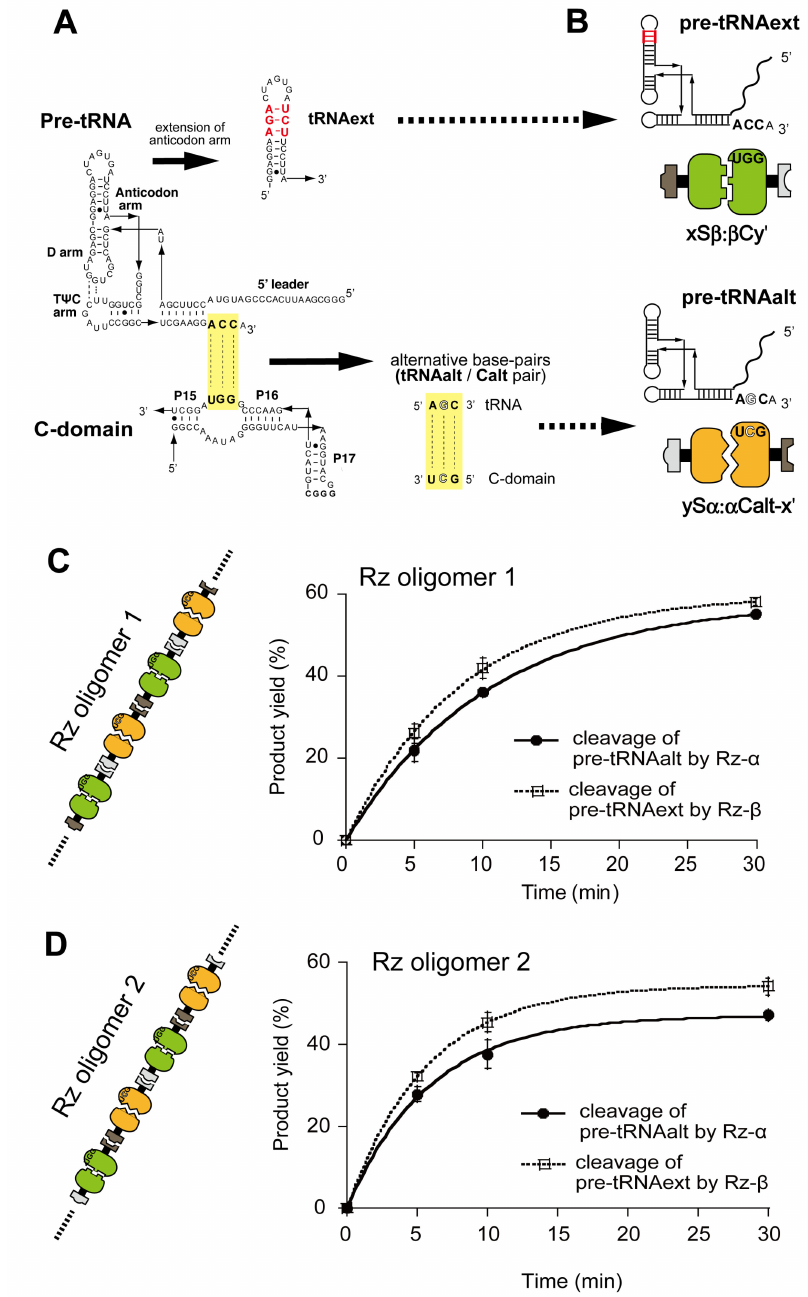
Figure 4. Catalytic activities of Rz- α and Rz- β measured separately in their alternating co-oligomers. ( A ) Engineering to generate an alternative base pair interaction between substrate pre-tRNA and the catalytic domain of RNase P ribozyme and pre-tRNA with an extended anticodon loop. ( B ) Two pairs of pre-tRNA and bimolecular ribozyme. Rz- β was paired with the pre-tRNA with an extended anticodon loop. The alternative base pair interaction was utilized to pair Rz- α and pre-tRNA. ( C , D ) Catalytic activities of Rz- α and Rz- β in Rz oligomer 1 ( C ) and Rz oligomer 2 ( D ) in the presence of 30 mM Mg 2+ . Activities of Rz- α and Rz- β were examined with the cleavage of pre-tRNAalt and pre-tRNAext, respectively. The concentration of each RNA component was 0.5 µ